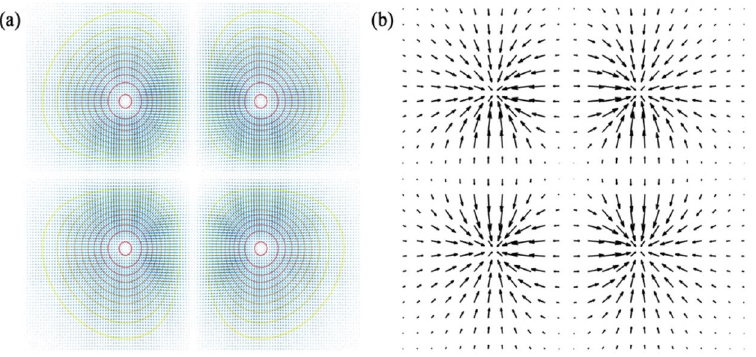
Figure 2. ( a ) Contour plot of the intensity and ( b ) gradient field of SMGBs in the plane perpendicular to the axis of propagation. The colors represent the magnitudes of radiation forces in ( a ). The directions and lengths of the black arrows in ( b ) represent the directions and magnitudes of the resultant